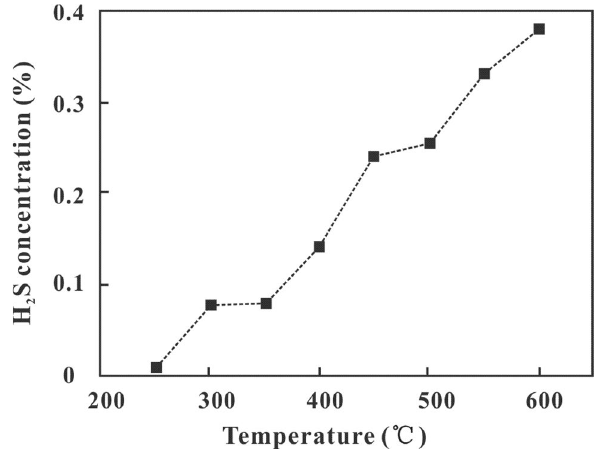
Figure 3. Correlation between temperature and H 2 S